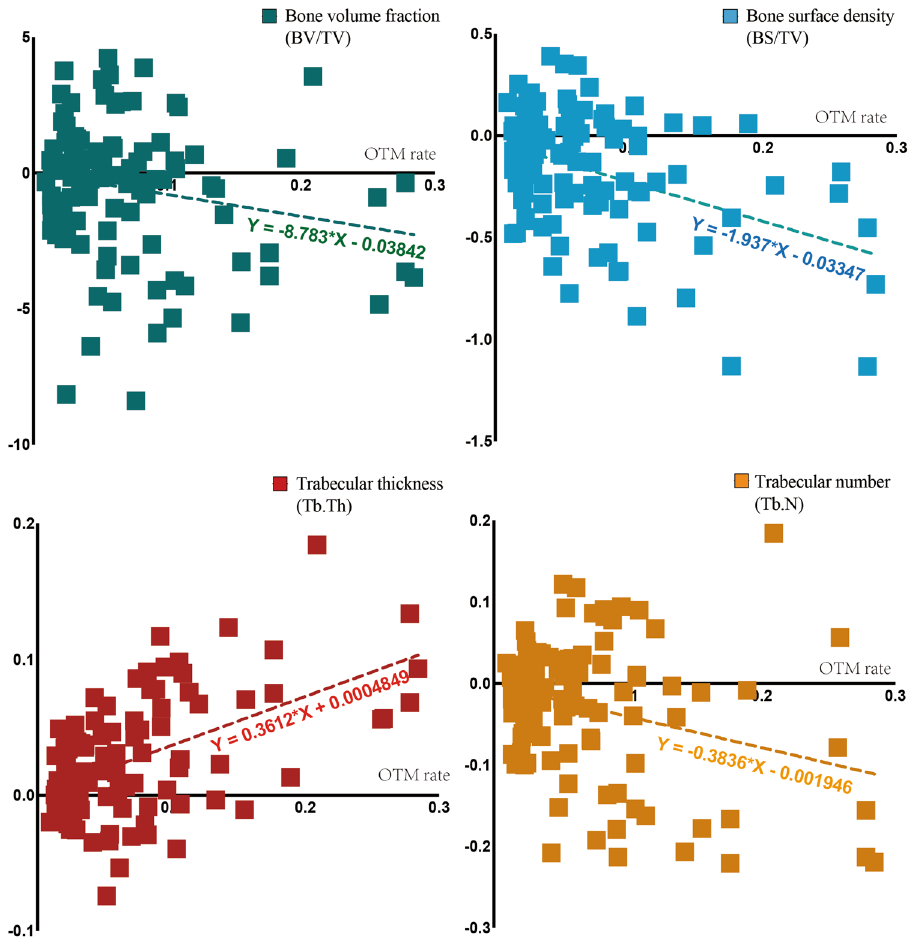
Figure 8. Agreement between the changes in OTM rate and bone morphometry. The OTM rate negatively correlated with bone volume and trabecular number, and positively correlated with trabecular thickness (n = 12, P < 0.05). Besides, there is no significant linear correlation between the OTM rate and BMD or trabecular separation ( P > 0.05, not shown in this